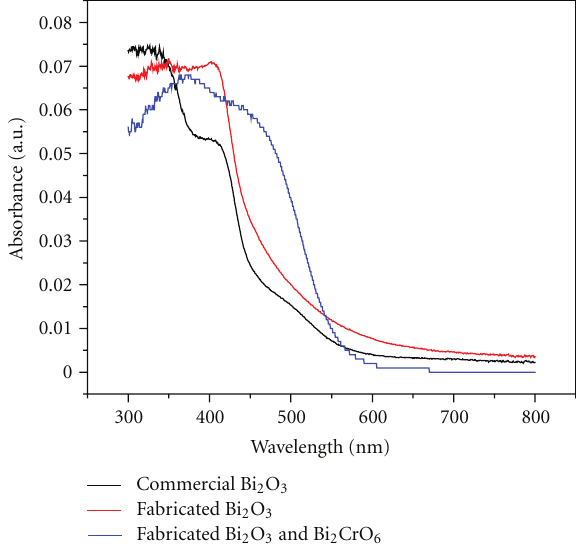
Figure 4: The UV-visible di ff use reflectance spectra of commer- cial Bi 2 O 3 , fabricated Bi 2 O 3, and the composite Bi 2 O 3 -Bi 2 CrO 6 nanowires. and can be used as a visible light photocatalyst to decompose the organic pollution. Compared with commercial and fabricated Bi 2 O 3 , the light absorption of Bi 2 O 3 -Bi 2 CrO 6